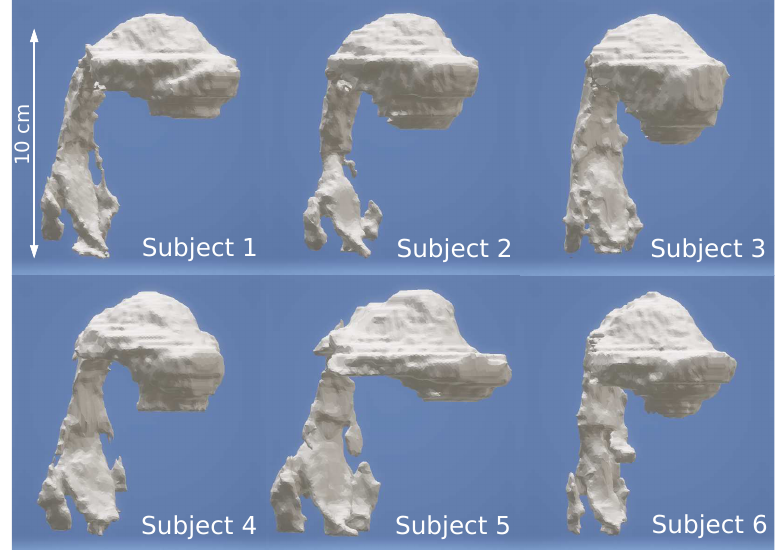
Figure 1. Segmented VTs of the six